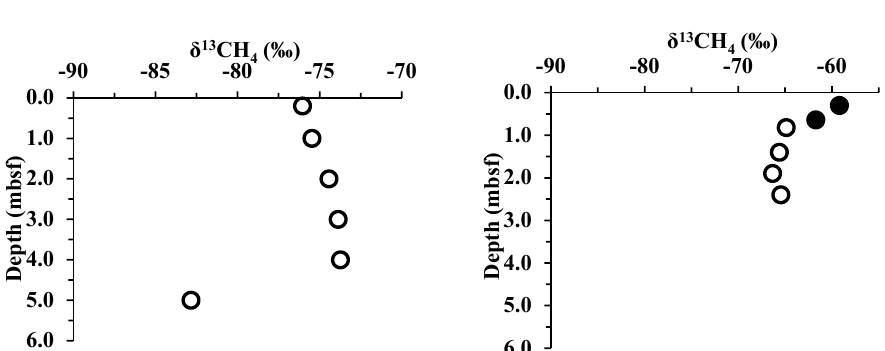
Figure 4. Diagrams showing the changes in the isotopic compositions with depth in sites of Amazon fan and northwest continental slope. Open and solid circles indicate dissolved gases in pore water and hydrate-bound gases,